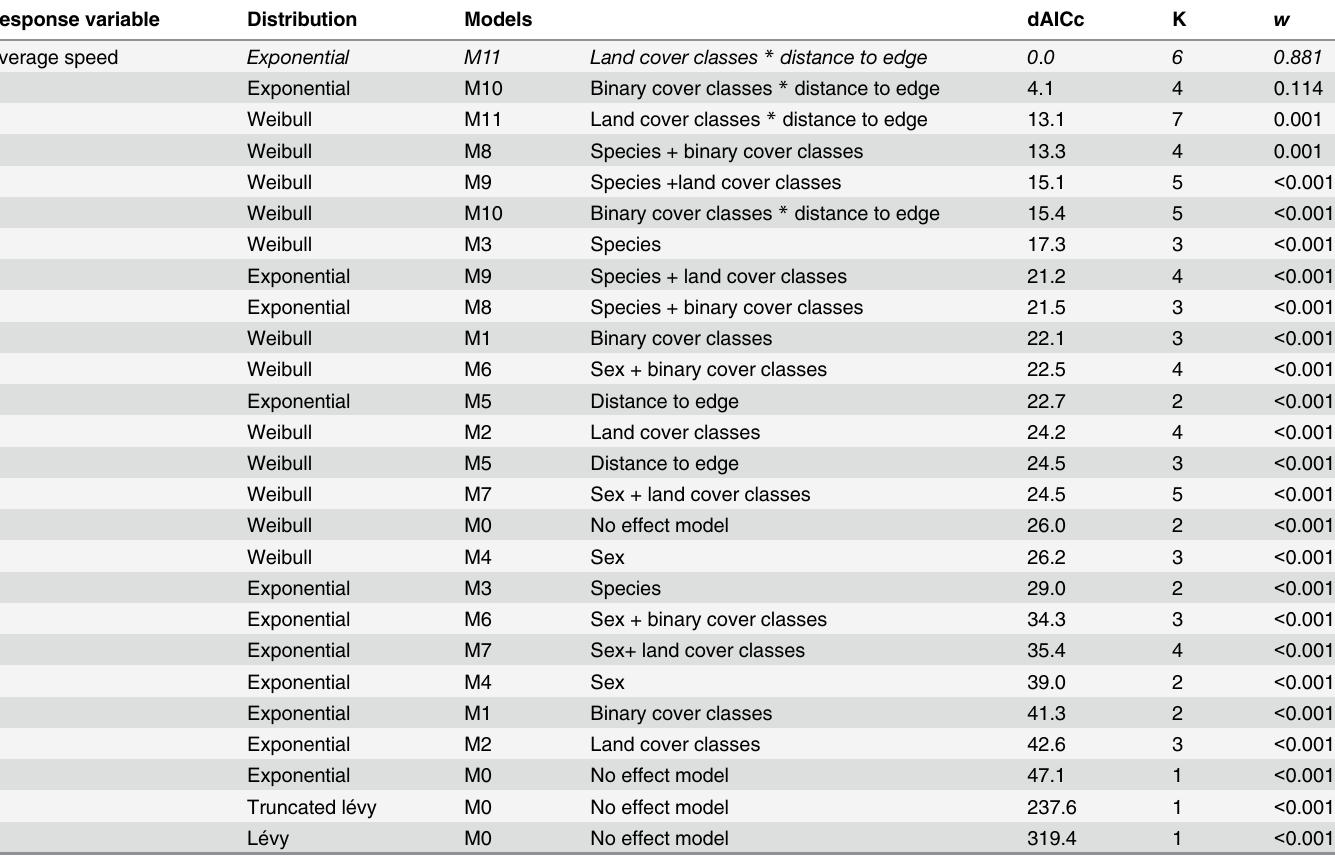
Table 1. Competing models describing average speed for Turdus leucomelas and T . rufiventris . Plausible model in italic. K is the number of estimated parameters and the w is the Akaike weights (relative likelihood of the model). Response